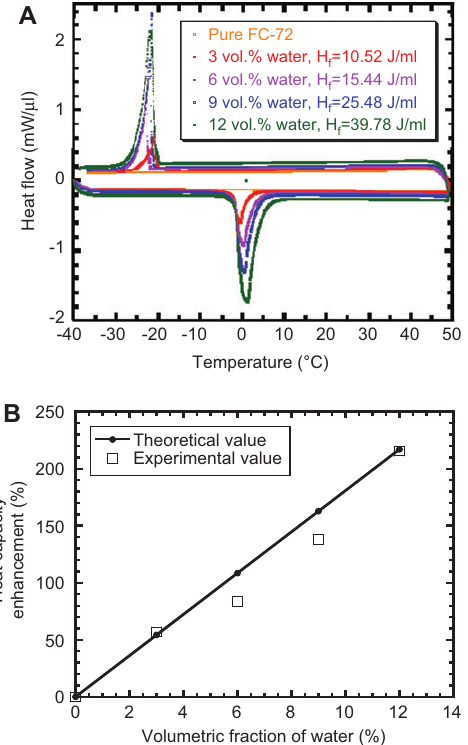
Figure 13 (A) The DSC cyclic curves of the water in the FC-72 nano- emulsion fluids with the different water loadings. (B) The measured and calculated heat capacity enhancement in the water in the FC-72 nanoemulsion fluids. The dispersed water droplets undergo the solid-liquid phase